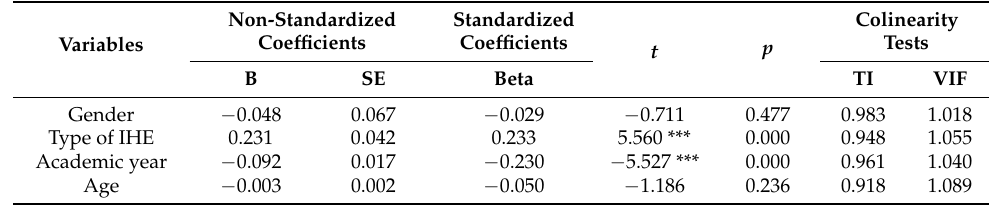
Table 5. Regression analysis regarding satisfaction with the infrastructure.